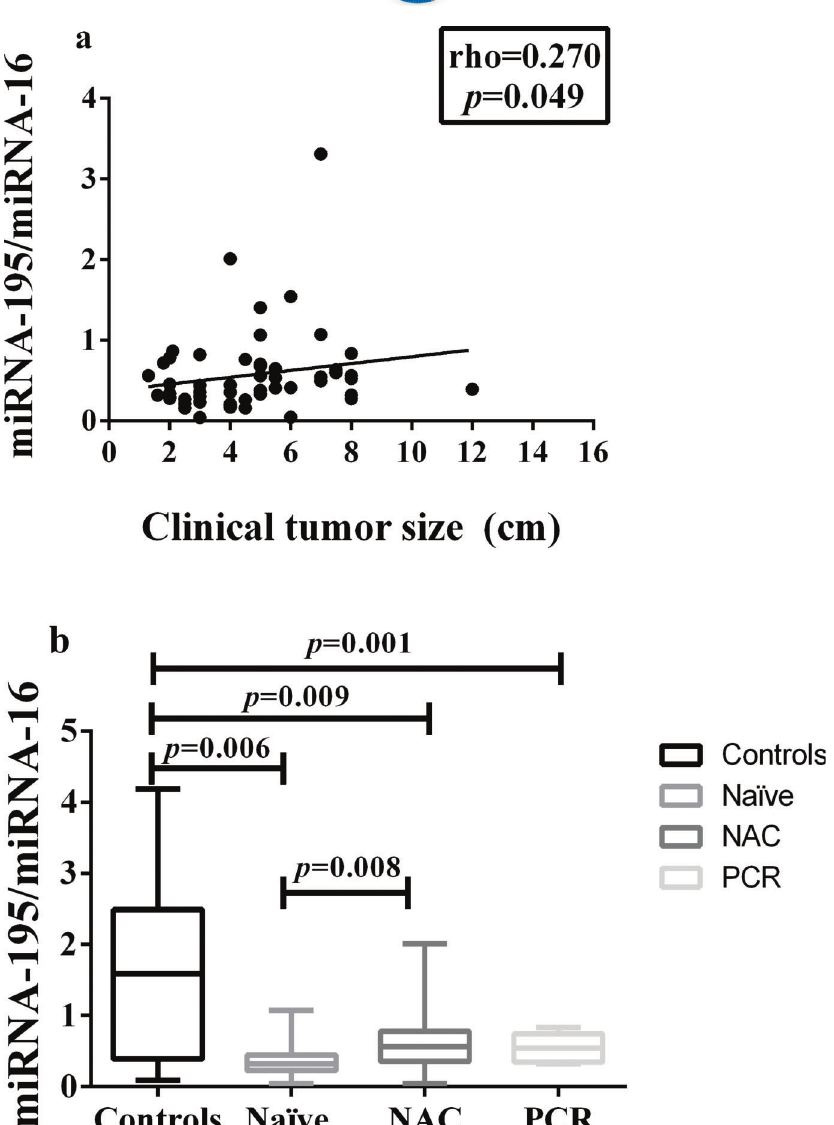
Figure 2 - Correlation between miRNA-195 Expression and Tumor Size or Response to Neoadjuvant Chemotherapy. a ) Correlation between miRNA-195 expression and tumor size (cm) (Spearman ’ s rank correlation coefficient). b ) miRNA-195 expression following exposure to NAC (or not) and achievement of PCR (the miRNA-195/miRNA-16 ratios were calculated using the 2 - DD Ct method). The expression values are presented as the DD Cq values on a log 2 scale (generalized linear model). The data are presented as the means ± SE values. PCR, pathological complete response; NAC, neoadjuvant chemotherapy; Naı¨ve, chemotherapy-